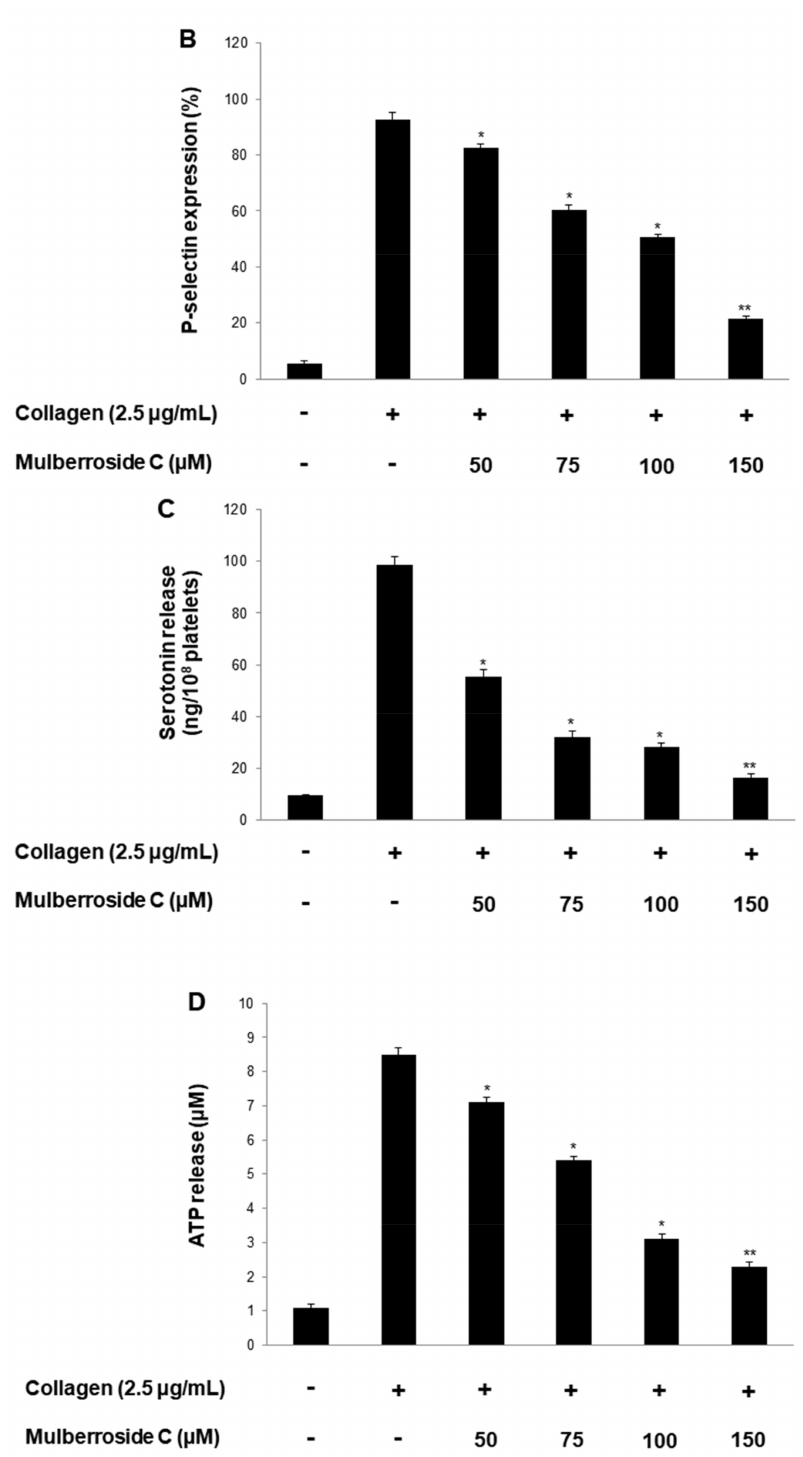
Figure 4. Effects of mulberroside C on p-selectin expression, serotonin, ATP release. ( A ) The flow cytometry histograms on p-selectin expression; ( B ) Effects of mulberroside C on collagen-induced p-selectin expression (%); ( C ) Effects of mulberroside C on collagen-induced serotonin release; ( D ) Ef- fects of mulberroside C on collagen-induced ATP release. Determination of p-selectin expression, sero- tonin, ATP was carried out as described in Section 2. The data are expressed as the mean ± standard deviation ( n = 4). * p < 0.05, ** p < 0.01 versus the collagen-stimulated human